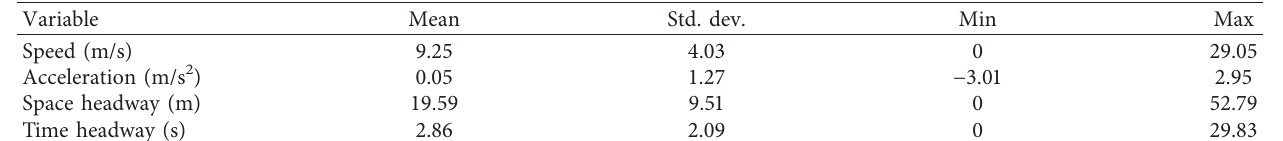
Table 2: Descriptive statistics of selected dataset.